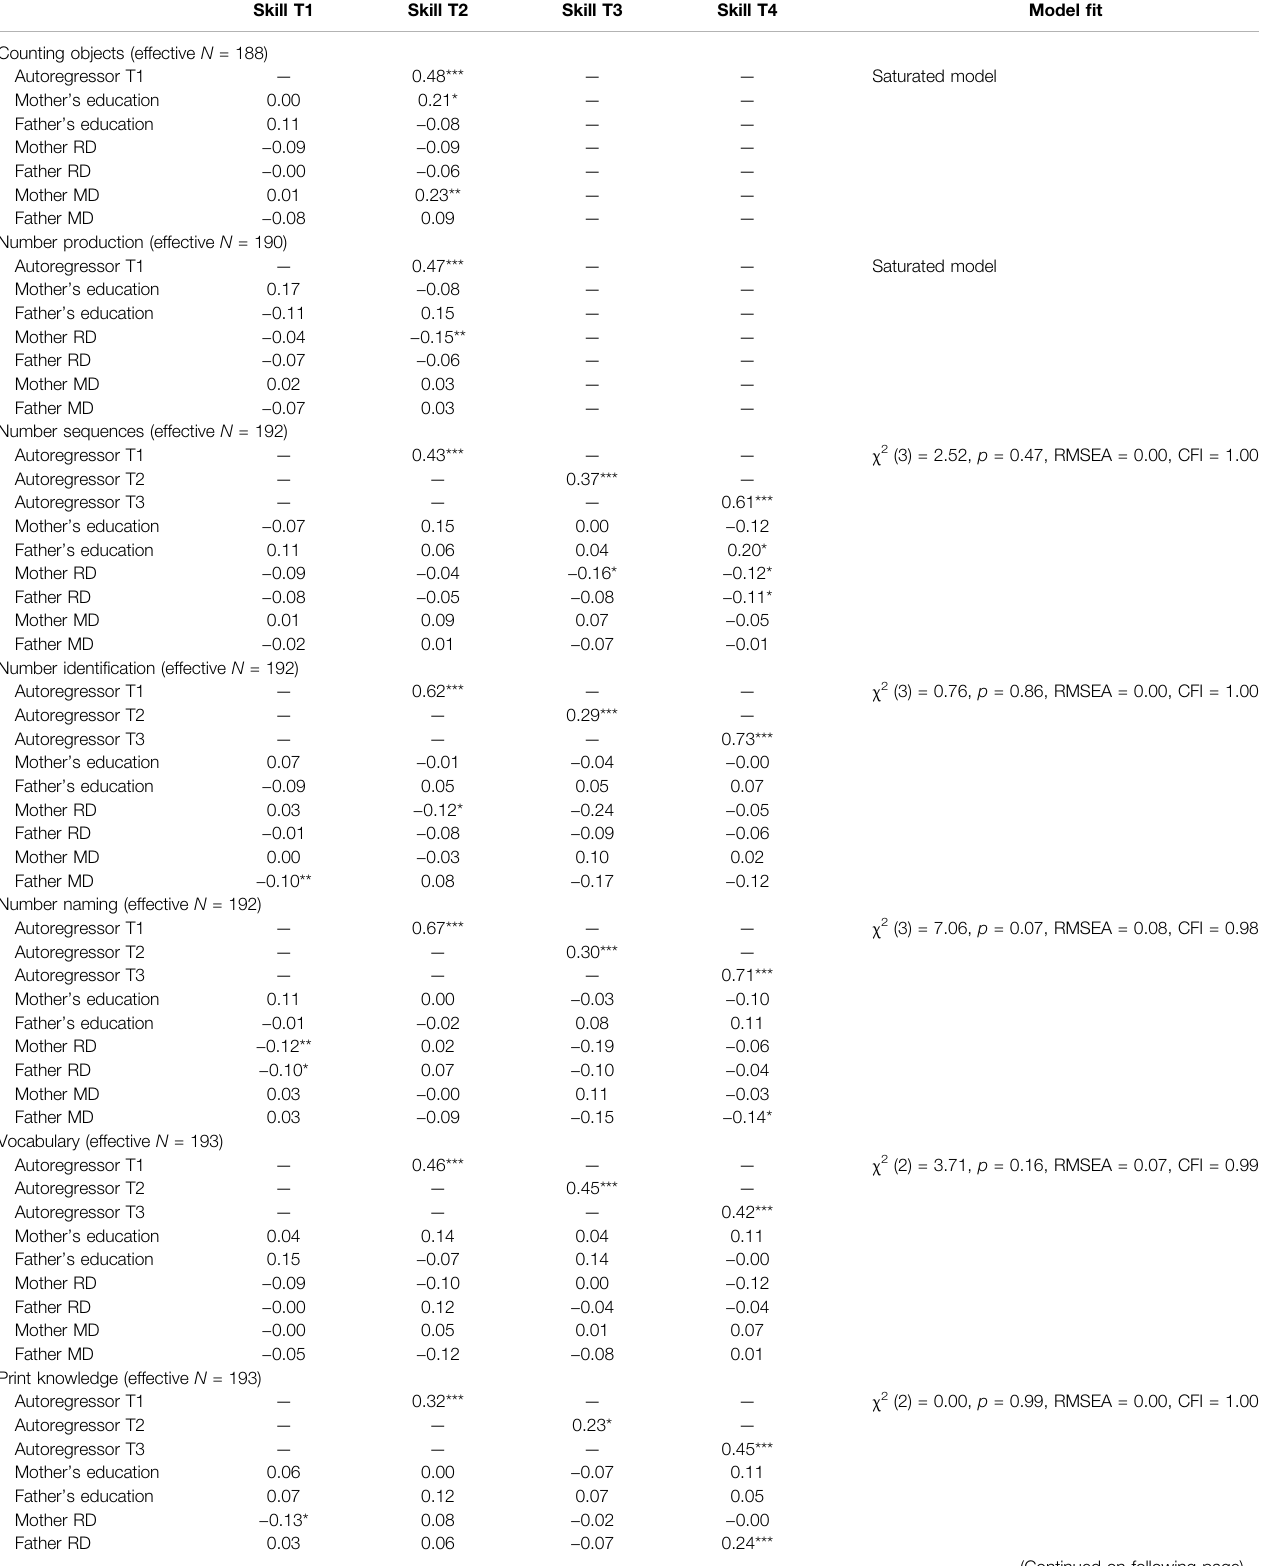
TABLE 3 | The standardized model estimates for parental measures predicting children ’ s